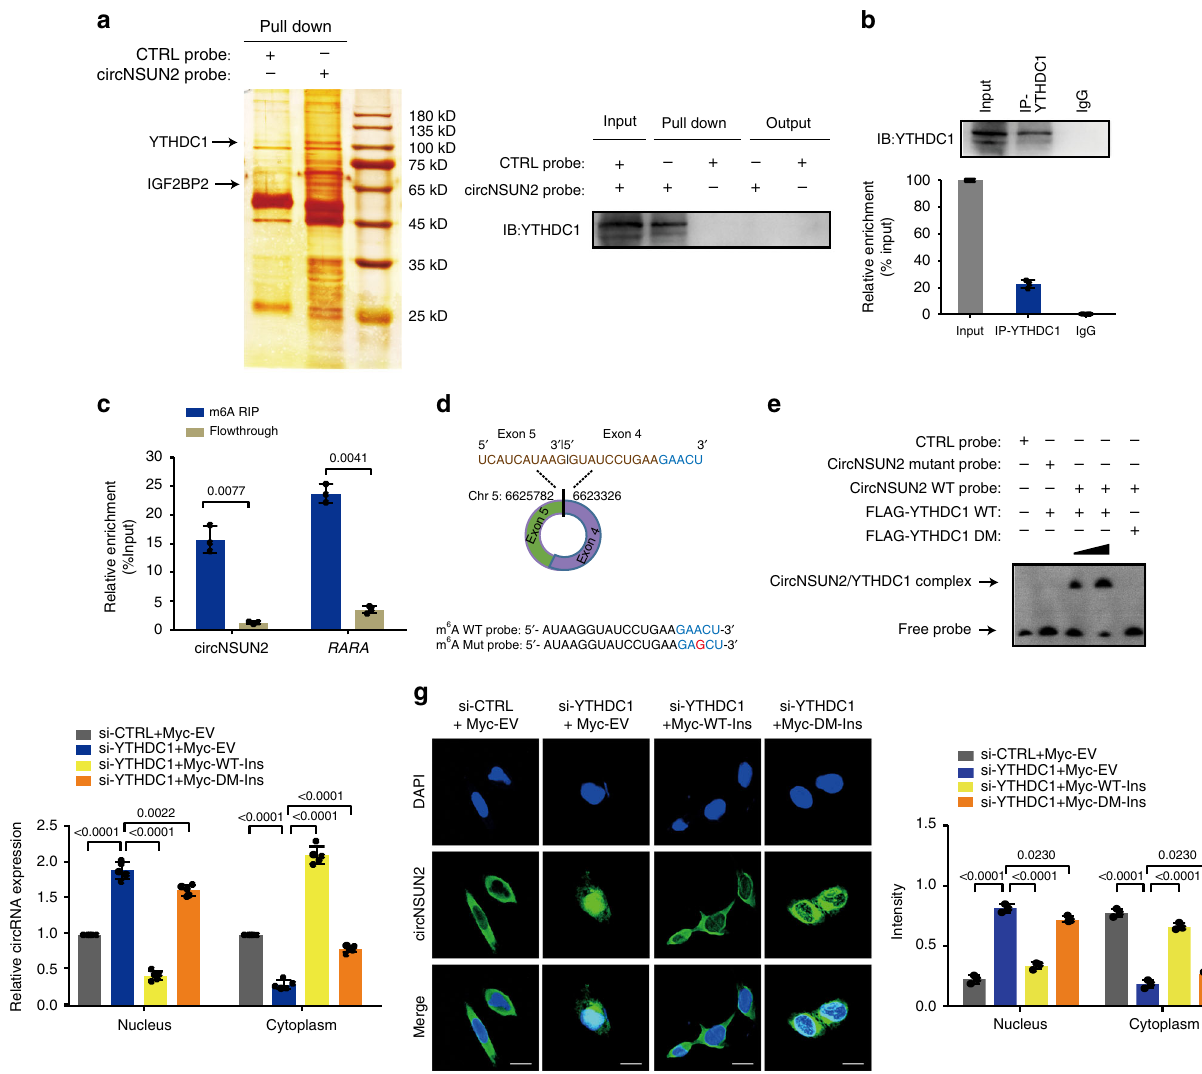
Fig. 4 YTHDC1 promotes cytoplasmic export of m 6 A methylated circNSUN2. a Left, identi fi cation of the circNSUN2-protein complex pulled down by circNSUN2 junction probe with protein extracts from HCT116 cells. The arrows indicating the additional band presented in circNSUN2-protein complex. Right, immunoblot analysis of YTHDC1 after pulldown assay showing its speci fi c association with circNSUN2. b RIP assays showing the association of YTHDC1 with circNSUN2. Top, IP ef fi ciency of YTHDC1-antibody shown in western blotting. Bottom, relative enrichment representing RNA levels associated with YTHDC1 relative to an input control. IgG antibody served as a control. Data represent mean ± S.D. from three independent experiments; dot plot re fl ects data points from independent experiment. c MeRIP assay showing that circNSUN2 was highly recruited in m 6 A precipitated fraction. Data represent mean ± S.D. from three independent experiments; dot plot re fl ects data points from independent experiment. The P values were determined by a two-tailed paired Student ’ s t test. d Top, schematic illustration showing the GAACU m 6 A motif located at exon 5 − exon 4 junction site of circNSUN2. Bottom, the sequence of RNA probe for RNA-EMSA assay. e RNA-EMSA assay showing the binding ability of puri fi ed YTHDC1 with biotin-labeled oligonucleotides containing GAACU motif from circNSUN2. f Cytoplasmic and Nuclear mRNA Fractionation experiment showing that knockdown of YTHDC1 increased the nuclear circNSUN2 content, whereas the dysregulation of nuclear circNSUN2 caused by YTHDC1 RNAi was recovered by overexpression of WT but not the mutant of YTHDC1. Data represent mean ± S.D. from fi ve independent experiments; dot plot re fl ects data points from independent experiment. The P values were determined by a two-tailed unpaired Student ’ s t test. g RNA-FISH showing that the increased nuclear staining of circNSUN2 caused by YTHDC1 RNAi was rescued by overexpression of WT, but not the mutant YTHDC1. Scale bar, 10 µ m. Data represent mean ± S.D. from three independent experiments; dot plot re fl ects data points from independent experiment. The P values were determined by a two-tailed unpaired Student ’ s t test. Source data are provided as a Source Data fi le. Unprocessed original scans of blots are shown in Supplementary Fig.